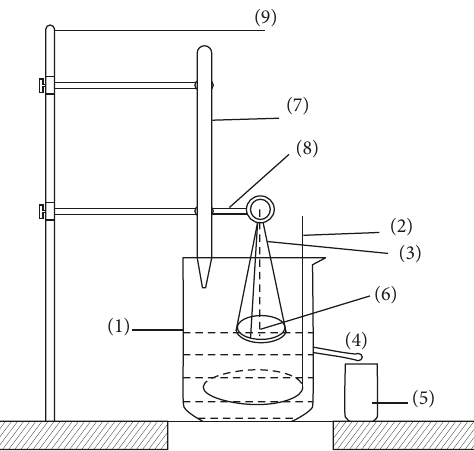
Figure 2: Schematic diagram of the transient dissolution instru- ment. ( 1 ) Glass beaker. ( 2 ) Stirrer rod. ( 3 ) Sample hanging rope. ( 4 ) Brine overflow tube. ( 5 ) Beaker. ( 6 ) Rock salt sample. ( 7 ) Fresh water infusion tube. ( 8 ) Clamp stand. ( 9 ) Iron